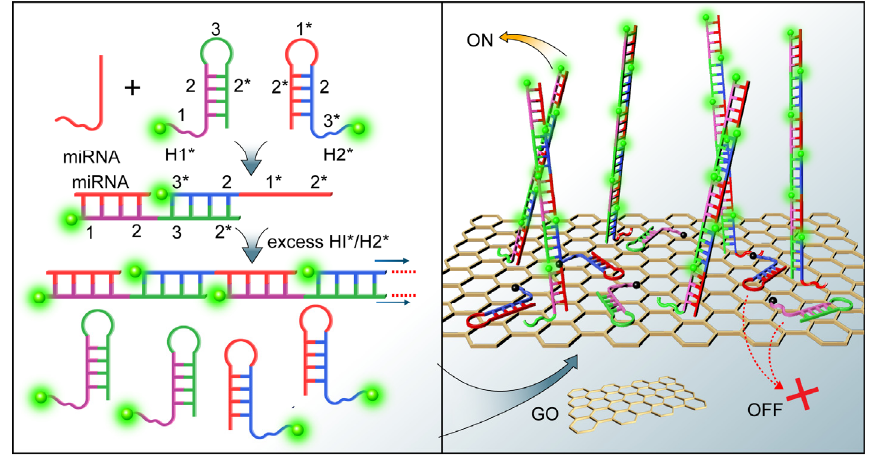
Figure 9. Schematic illustration of the proposed HCR/GO platform for miRNA